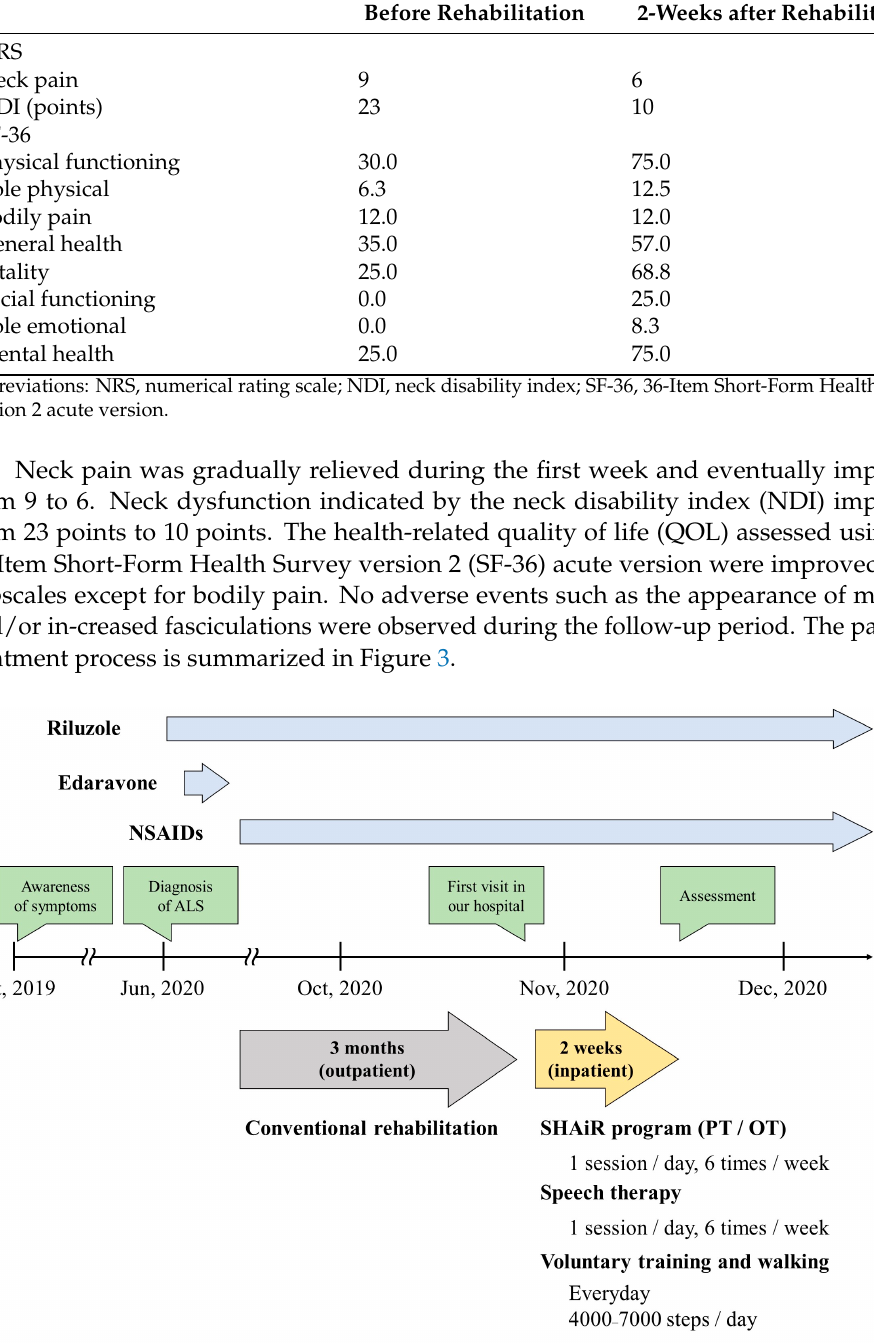
Figure 3. Timeline of patient’s treatment process. Abbreviation. NSAIDs, non-steroidal anti- inflammatory drugs; ALS, amyotrophic lateral sclerosis; SHAiR program, the short and intensive rehabilitation program; PT, physical therapist; OT, occupational